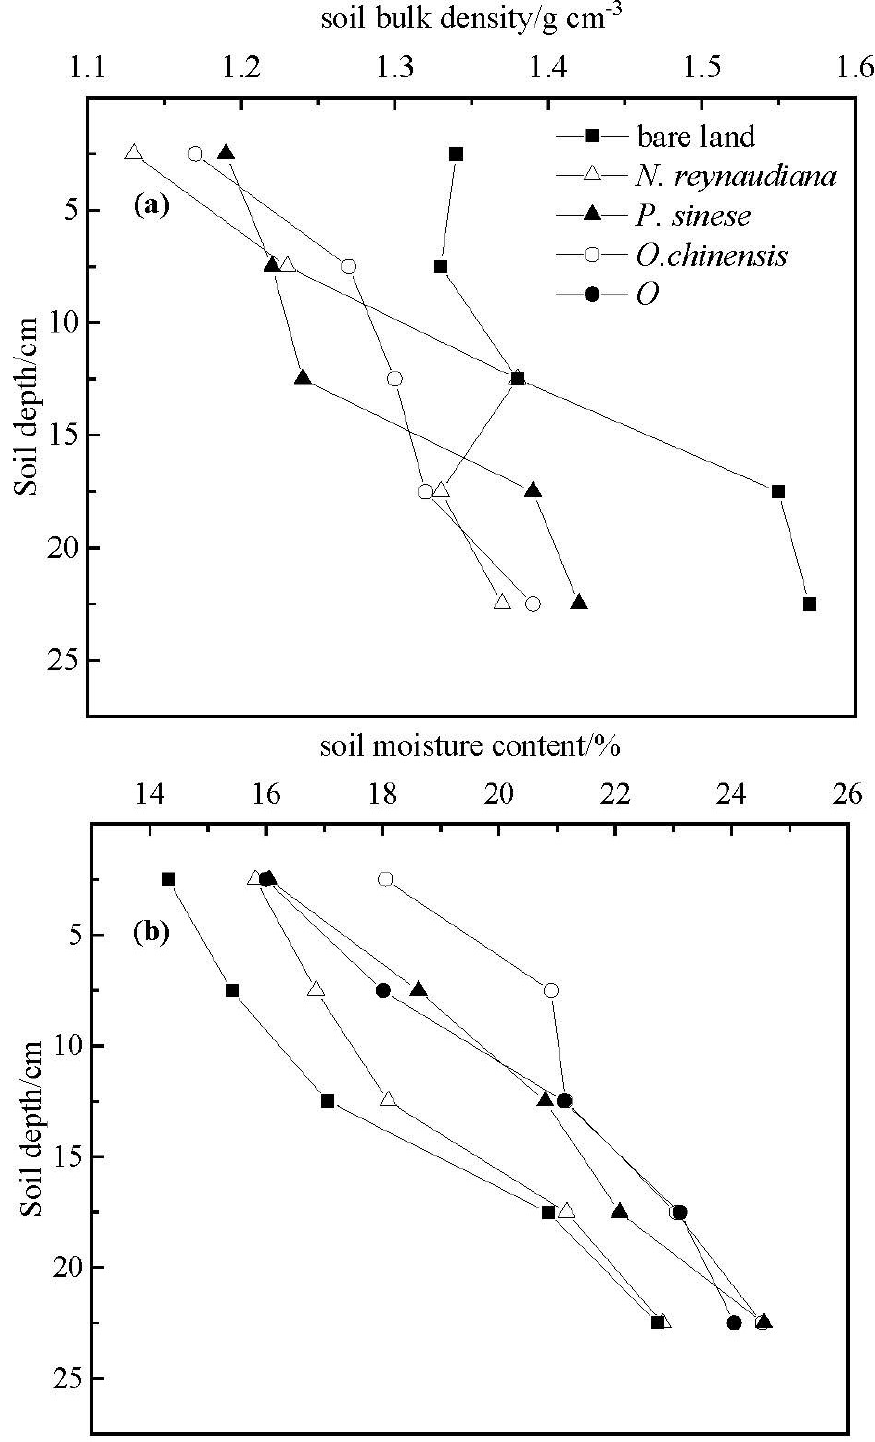
Figure 5. ( a ) Variation of soil moisture content with plant species. ( b ) Variation of soil bulk density with plant